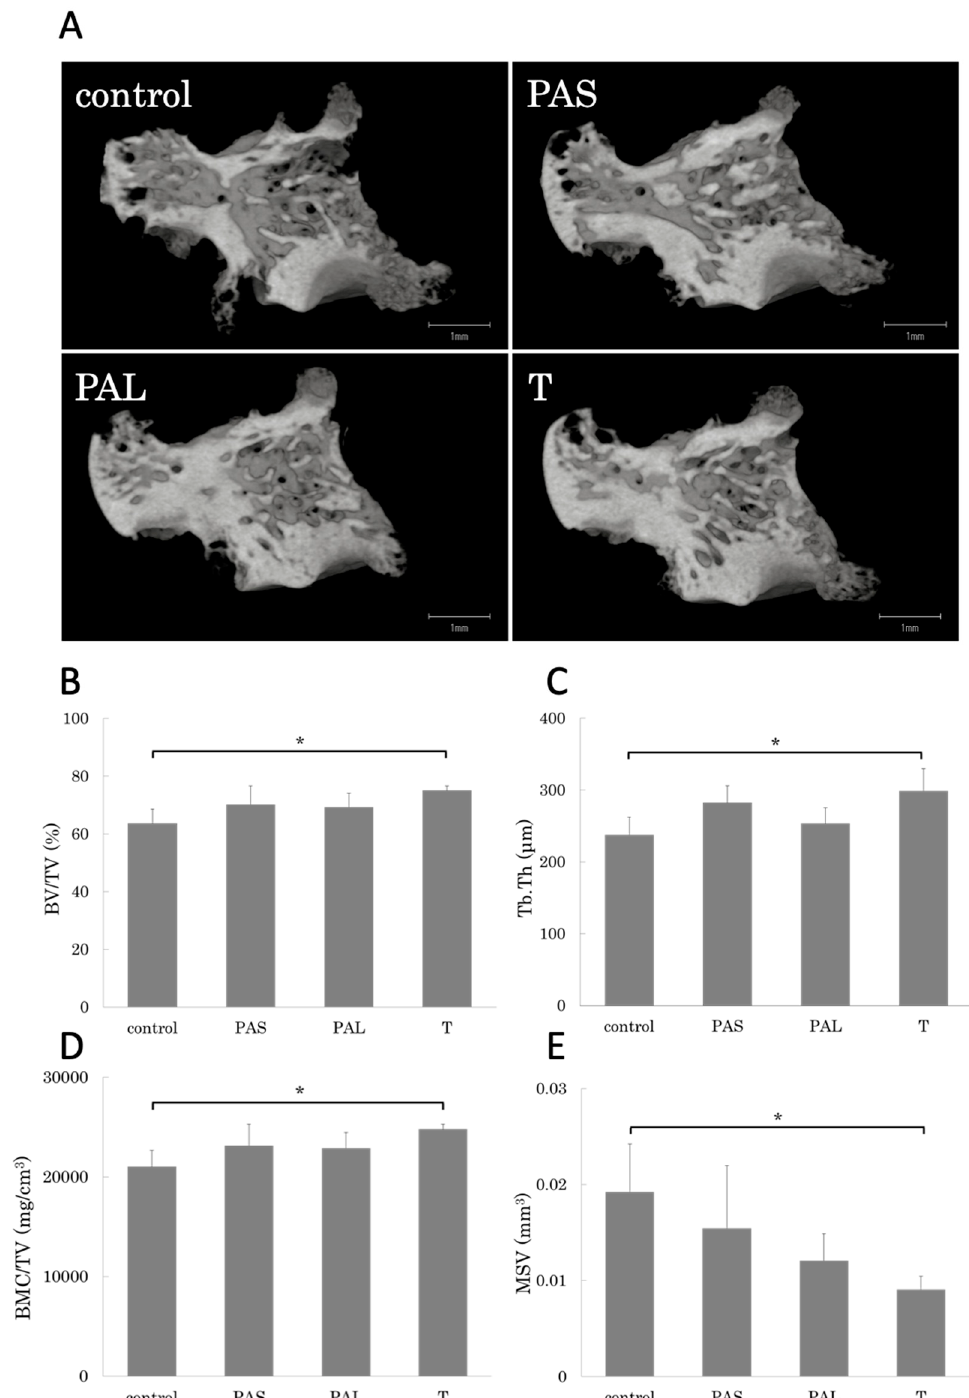
Figure 4. Representative three-dimensional reconstruction of (A ) the sagittal sections of the talus architecture. Trabecular bone parameters such as ( B ) bone volume fraction (BV / TV), ( C ) trabecular thickness (Tb.Th), ( D ) bone mineral content per tissue volume (BMC / TV), and ( E ) marrow star volume (MSV) of the whole talus are shown. T group had improved bone loss. n = 4 in each group. * p < 0.05.